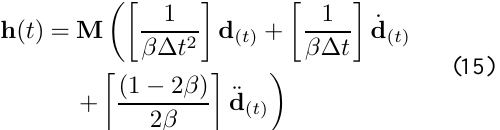
Fig. 9. The impactor velocity and the plate center velocity corresponding to Mesh